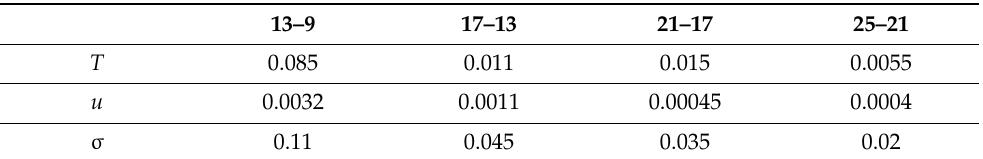
Table 5. The maximum norm for differences (upper row) for temperature, displacement, and stress in the space-time domain in layer 2.